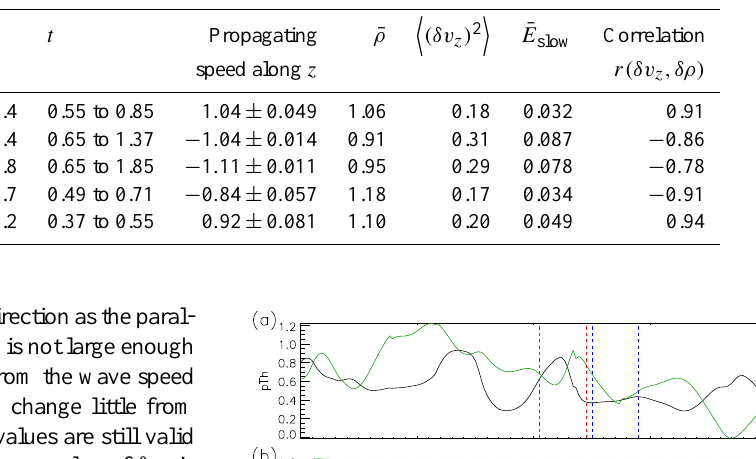
Table 2. Overview of the cases analyzed.